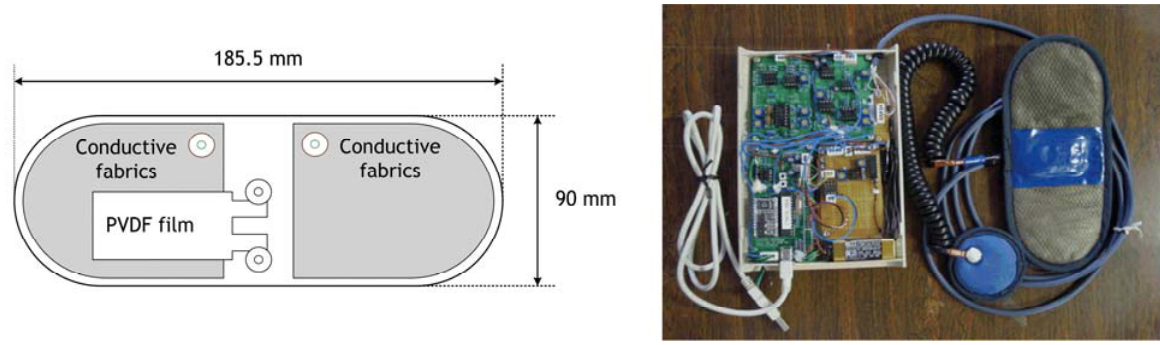
Figure 4. Schematic of the belt probe (left panel) and photograph of the cardiorespiratory belt sensor with the hardware for signals acquisition (right